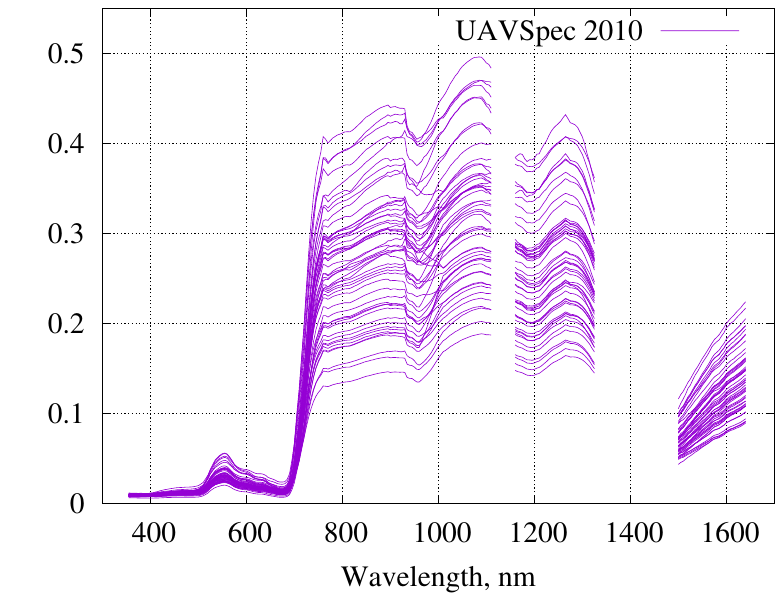
Figure 2. Reflectance spectra of forest stands on 5 July